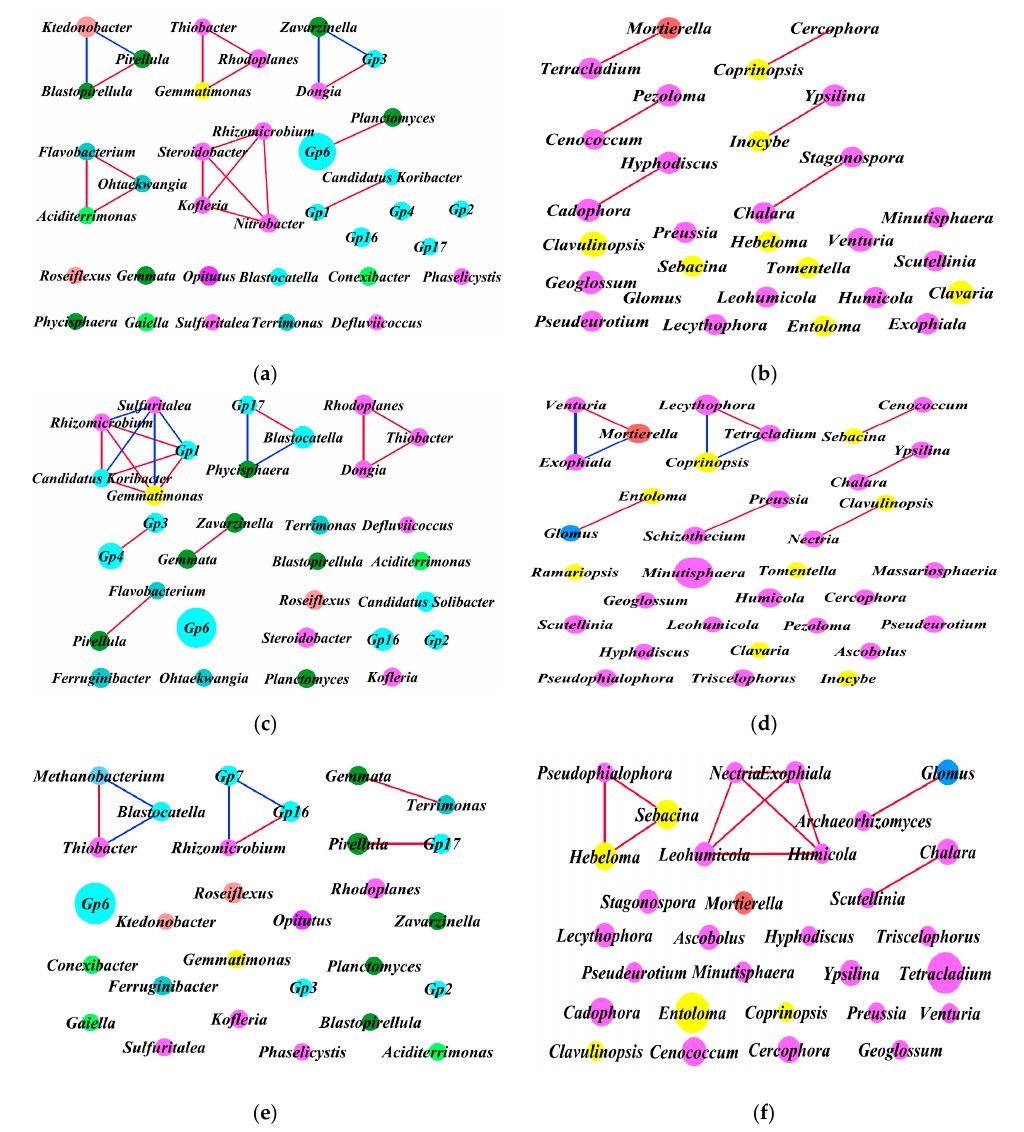
Figure 8. Intra-kingdom network of 40 most abundant co-occurring bacterial and fungal genera based on correlation analysis. Connecting lines represent strong (Spearman’s ρ > 0.6) and significant ( p < 0.01) correlation. Highly significant positive ( R > 0.80, false discovery rate (FDR) < 0.05) and negative ( R < − 0.80, FDR < 0.05) Pearson correlations are represented as red and blue lines. The size of each node is proportional to the degree, and nodes are colored by taxonomy. ( a , c , e ) Bacterial correlation patterns for sites A, B, and C, respectively. (cid:4) , (cid:4) , (cid:4) , (cid:4) , (cid:4) , (cid:4) , (cid:4) , and (cid:4) represent Acidobacteria , Actinobacteria , Bacteroidetes , Chloroflexi , Gemmatimonadetes , Planctomycetes , Proteobacteria , and Verrucomicrobia , respectively. ( b , d , f ) Fungal correlation patterns for sites A, B, and C, respectively. (cid:4) , (cid:4) , (cid:4) , and (cid:4) represent Ascomycota , Basidiomycota , Glomeromycota , and Zygomycota ,